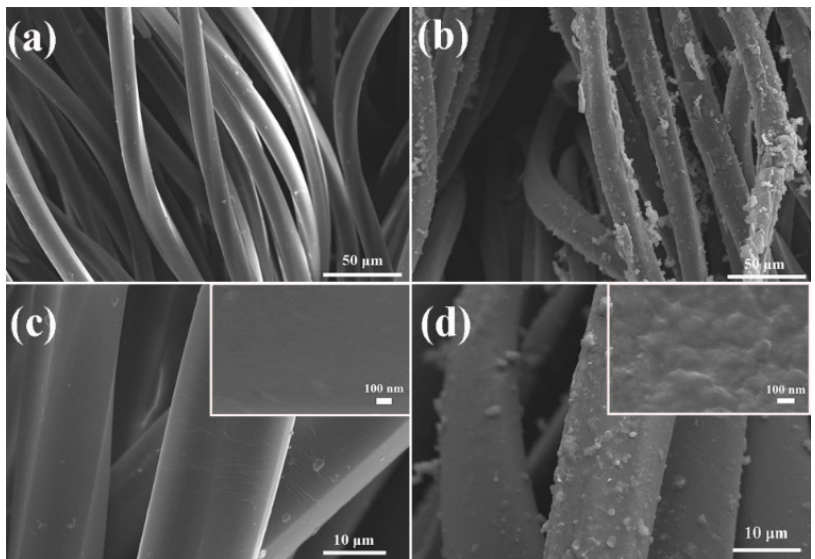
Figure 2. SEM images of pristine polyester/spandex textile at low ( a ) and high magnifications ( c ); SEM images of PPy-coated polyester/spandex textile at low ( b ) and high magnifications ( d ); and inset in ( c , d ): Detailed surface morphologies of the fibers before and after PPy coating, respectively.